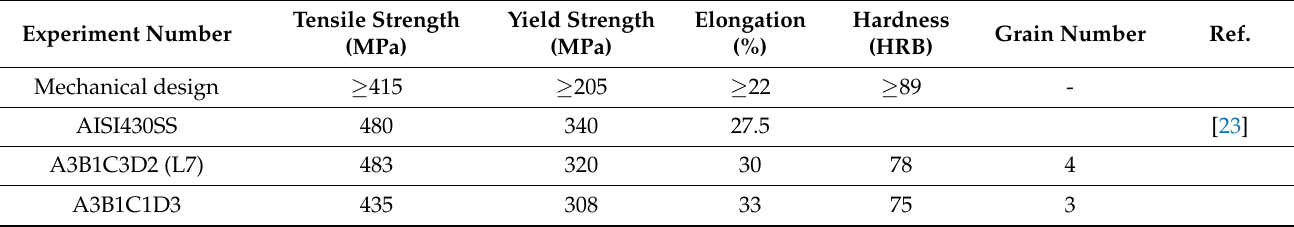
Table 9. Mechanical properties of samples A3B1C3D2 (L7) and